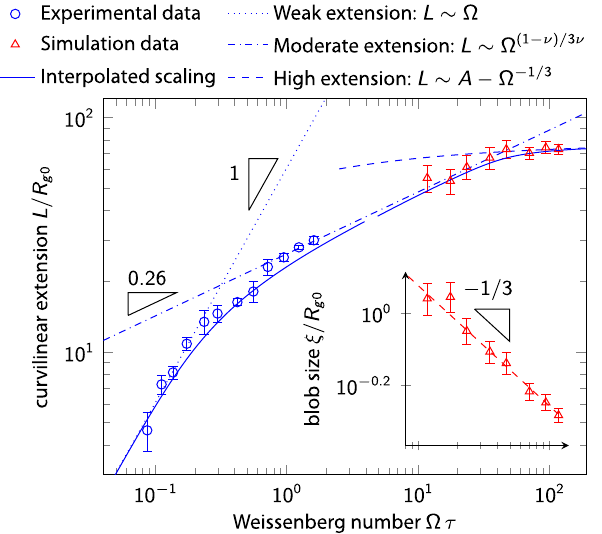
FIG. 4. Curvilinear end-to-end extension of untethered T4-DNA (166 kbp) and DPD polymers for varying rotation rates. The model-dependent shift between the high Weissenberg- number simulations and experiments is removed by setting the Wi ¼ 10 value to the fitted strong extension value. Dotted lines show the predicted scaling for weak extensions at low Wi [Eq. (2); L ∼ Wi]. Moderate extensions at intermediate Wi are shown as dash-dotted lines [Eq. (4); L ∼ Wi ð 1 − ν Þ = 3 ν ∼ Wi 0 . 26 ], while dashed lines show strong extensions at the highest Wi [Eq. (5)]. Inset: Blob size ξ of the DPD polymer. The dashed line shows the scaling predicted by Eq.